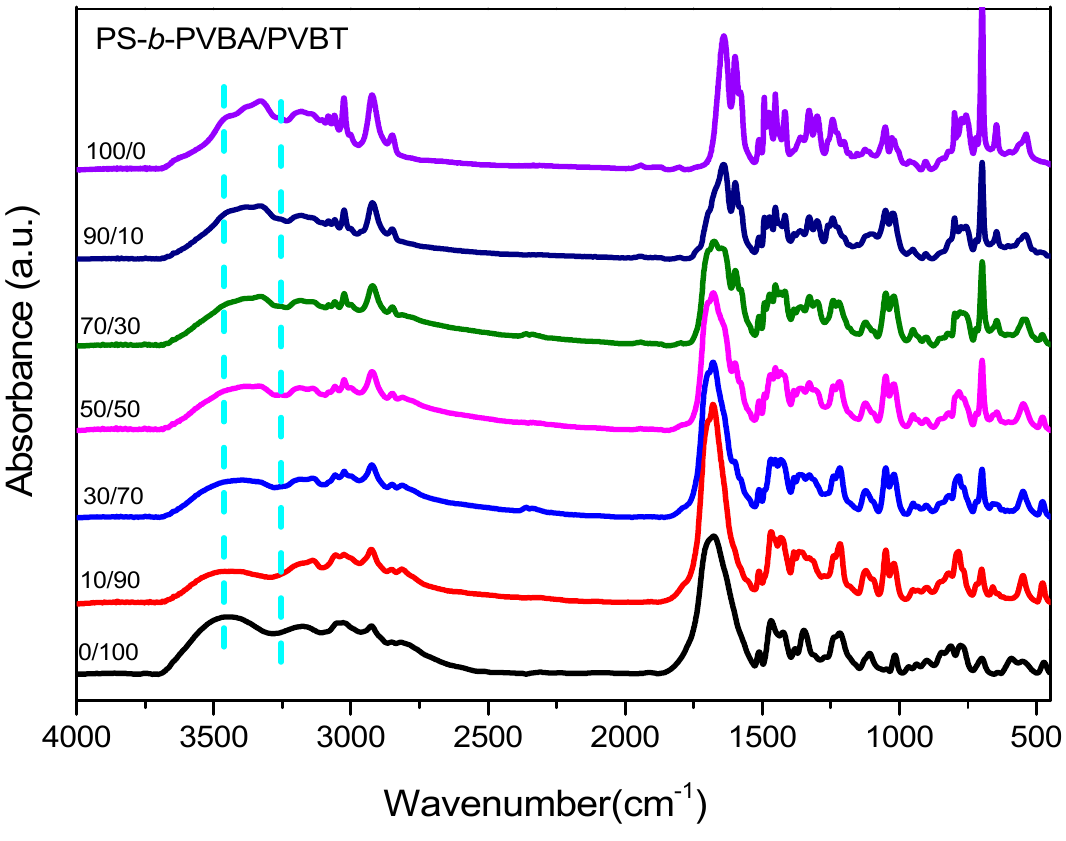
Figure 6. FTIR spectra of PS- b -PVBA/PVBT diblock copolymer/homopolymer blends of various compositions.